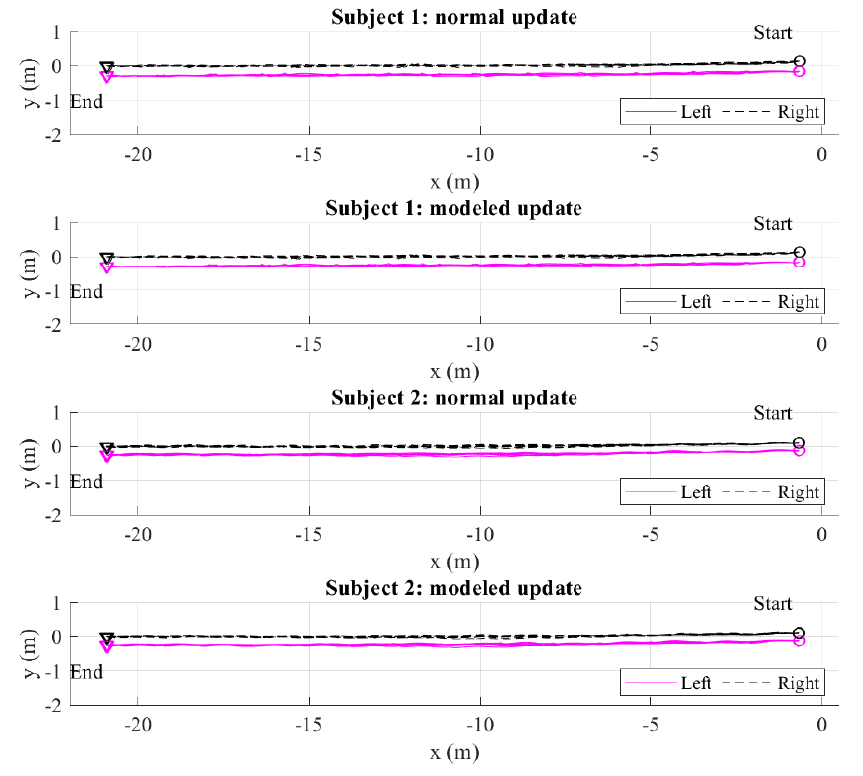
Figure 10. The total estimated 20 m walking trajectories of two subjects from the smoother algorithm in the normal and modeled